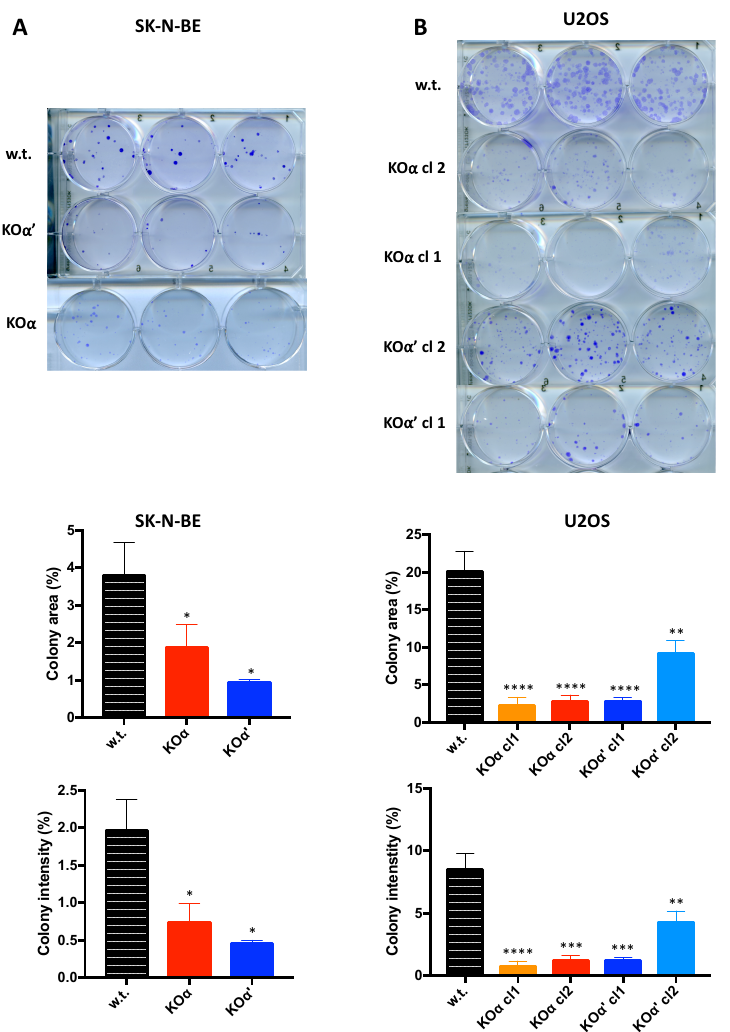
Figure 4. Clonogenic potential of w.t. and KO clones. ( A ) 250 SK-N-BE cells/well (w.t. or KO α clone 1, or KO α ’ clone 1), or ( B ) 100 U2OS cells/well (w.t. or clones as indicated) were plated, then grown for 15 days. Colonies were stained with Crystal violet, and images were taken by a scanner device at day 15. At least two separate experiments in triplicate were performed; three representative images are shown for each clone. The bar graphs on the bottom show the quantification of the area covered by colonies (upper graph) and the colony intensity percentage (lower graph), which is related to the number of cells in a colony (mean values ± SEM). Significance refers to w.t. cells. (*) p < 0.05, (**) p < 0.01, (***) p < 0.001, (****) p <